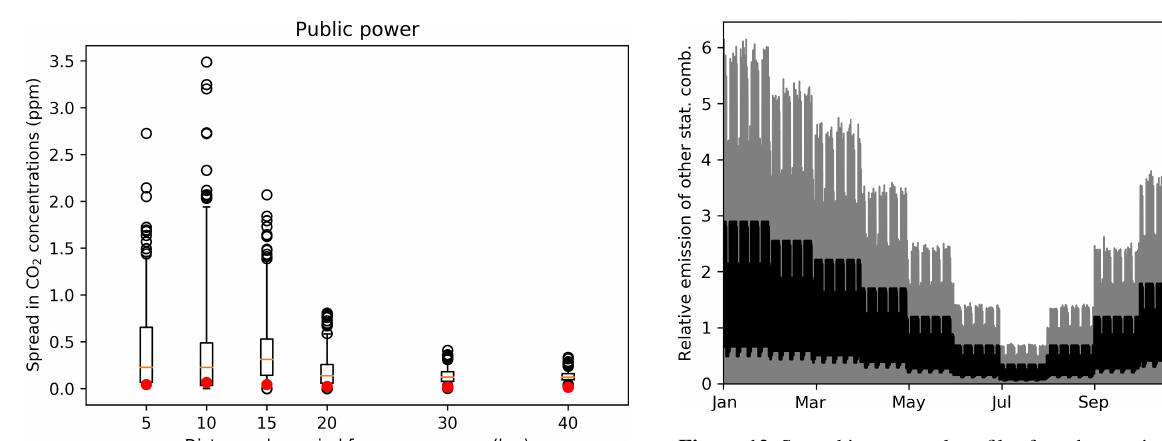
Figure 12. Spread in temporal profiles for other stationary combus- tion ( N = 500), resulting from the Monte Carlo simulation (grey shading). The black line represents the standard time